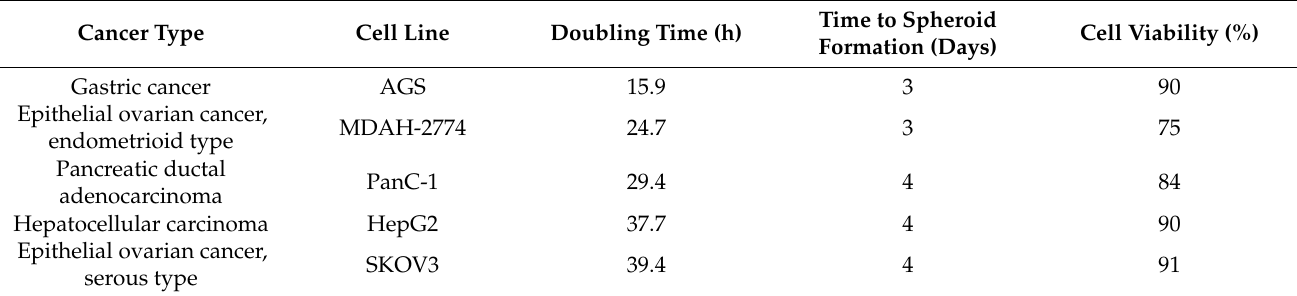
Table 2. Characteristics of different cancer cell lines grown in 3D culture.